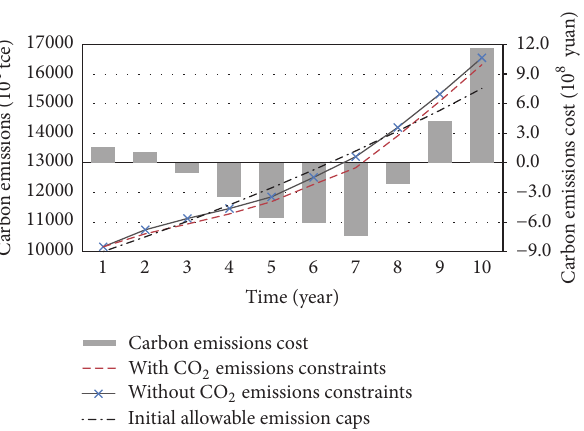
Figure 5: CO 2 emission amount and carbon emission